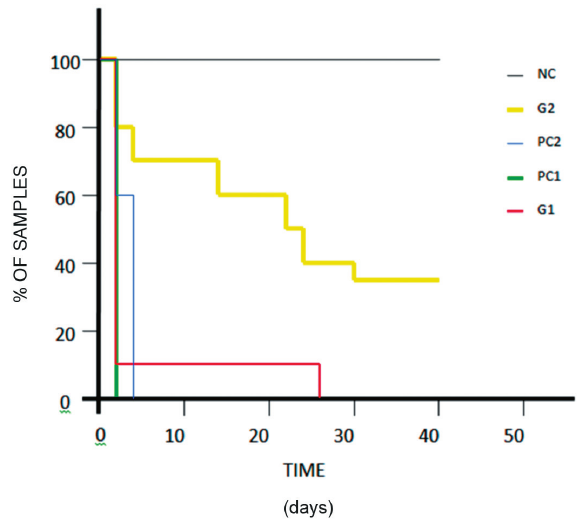
Figure 2- Possibility of recontamination of the root canals - Kaplan-Meier Survival Analysis test (P Table 1- Distribution of root canals exhibiting bacterial microleakage after 40 days